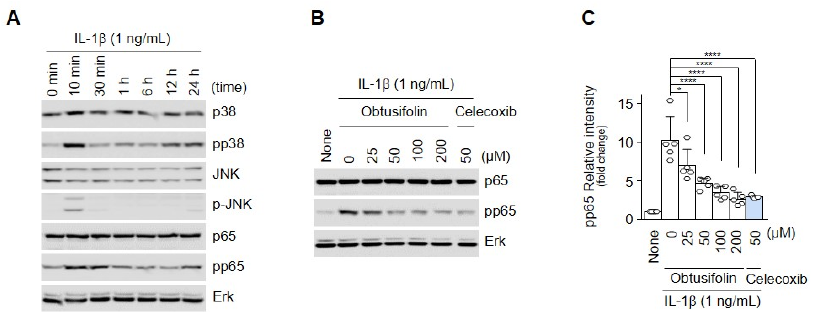
Figure 3. Obtusifolin regulates IL-1 β -induced NF- κ B phosphorylation. Chondrocytes were treated with IL-1 β (1 ng/mL) for the indicated time. After harvesting, signaling proteins were quantified by Western blotting ( A ). Chondrocytes were treated with obtusifolin at the indicated concentrations for 24 h, and IL-1 β (1 ng/mL) was added 10 min before harvest. pp65 was detected by Western blotting ( B ) and densitometry ( C ). Erk was used as the loading control in Western blotting. Data of each group ( n = 5) are shown as mean ± SEM; * p < 0.05 and **** p <